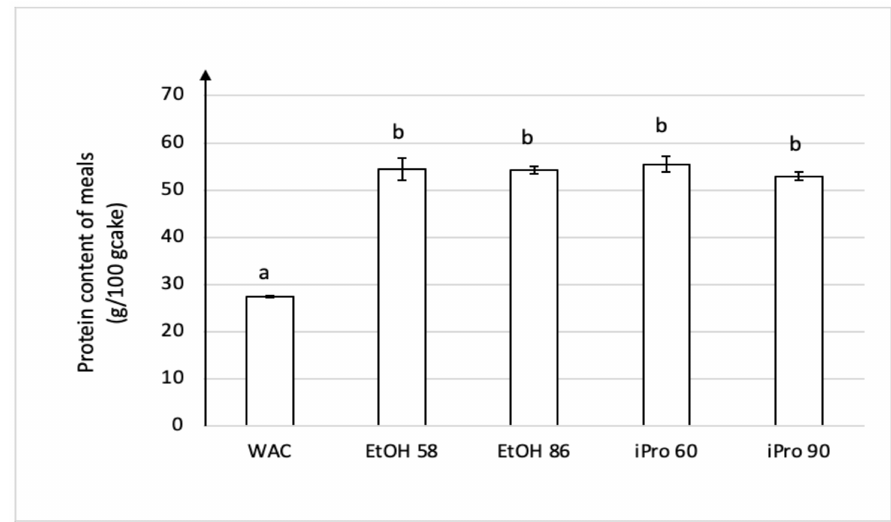
Figure 2. Protein content of meals obtained after extraction with hydro-alcoholic solvents followed by Soxhlet defatting with hexane. WAC label corresponds to the untreated walnut cake. ab Different letters mean significantly different values at p < 0.05.